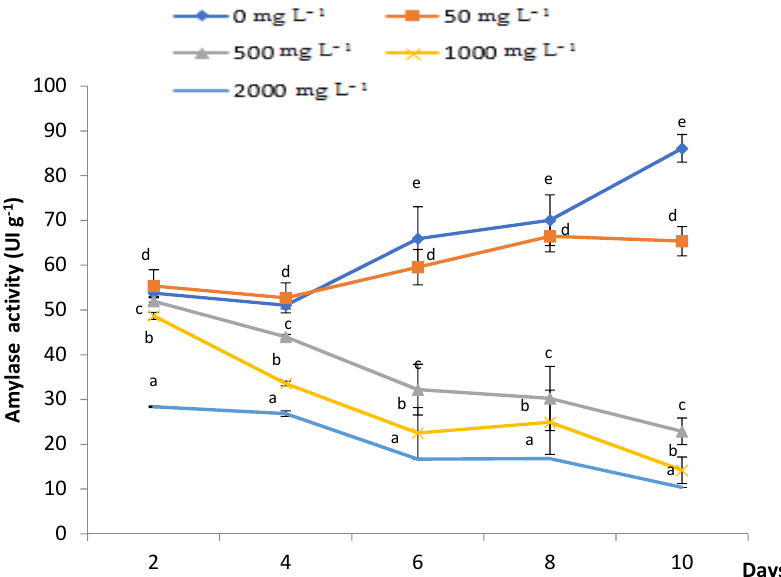
Figure 2. Monitoring of the effects of PbCl 2 treatment (0, 50, 500, 1000 and 2000 mg L − 1 ) on α -amylase activity of treated fenugreek seeds over 10 days. All the values are means of three triplicates ± SD of 10 seeds each. ANOVA is significant at p < 0.05. Different letters indicate significantly different values at a particular duration between different treatments (DMRT, p < 0.05).